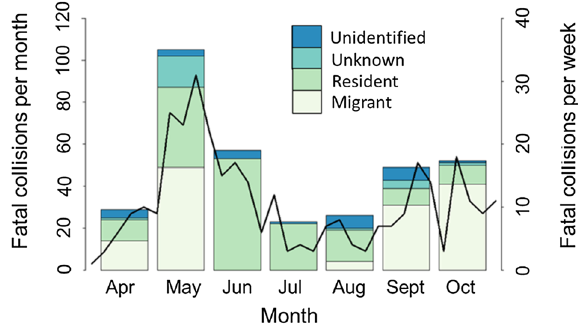
Figure 2. Monthly and weekly variation in bird-window collisions. Monthly (left vertical axis and bars) and weekly (right vertical axis and black line) numbers of fatal collisions (including feather piles) by residency status of individual birds from collision monitoring in Stillwater, Oklahoma, USA in 2015–2016. See “Methods” for details regarding designation of residency status